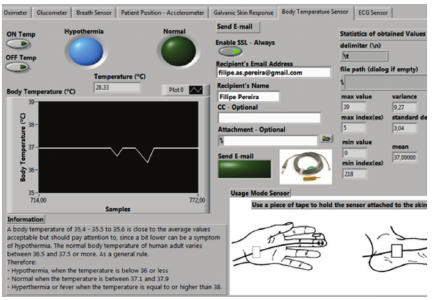
Figure 17: Obtaining the body temperature profile in the MCT